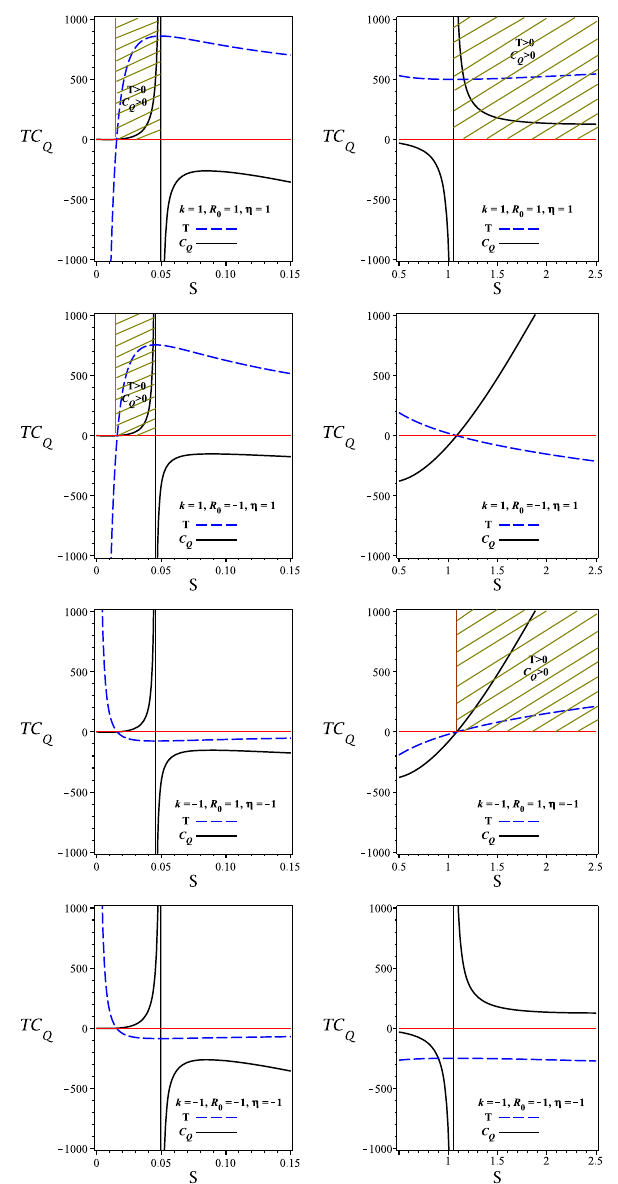
Fig. 2 The heat capacity ( C Q ) and temperature ( T ) versus S for Q = 0 . 02 and f R = 0 . 1. We plot them in different scales in order to be more